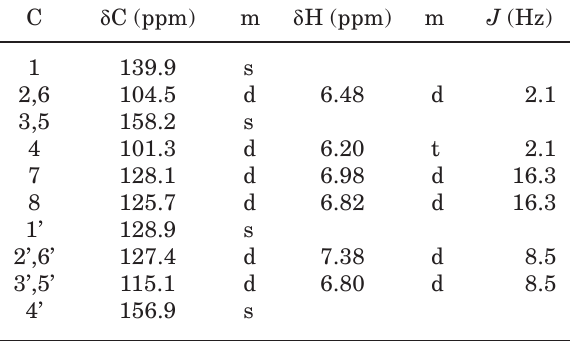
Table 2. 13 C and 1 H NMR data of resveratrol.